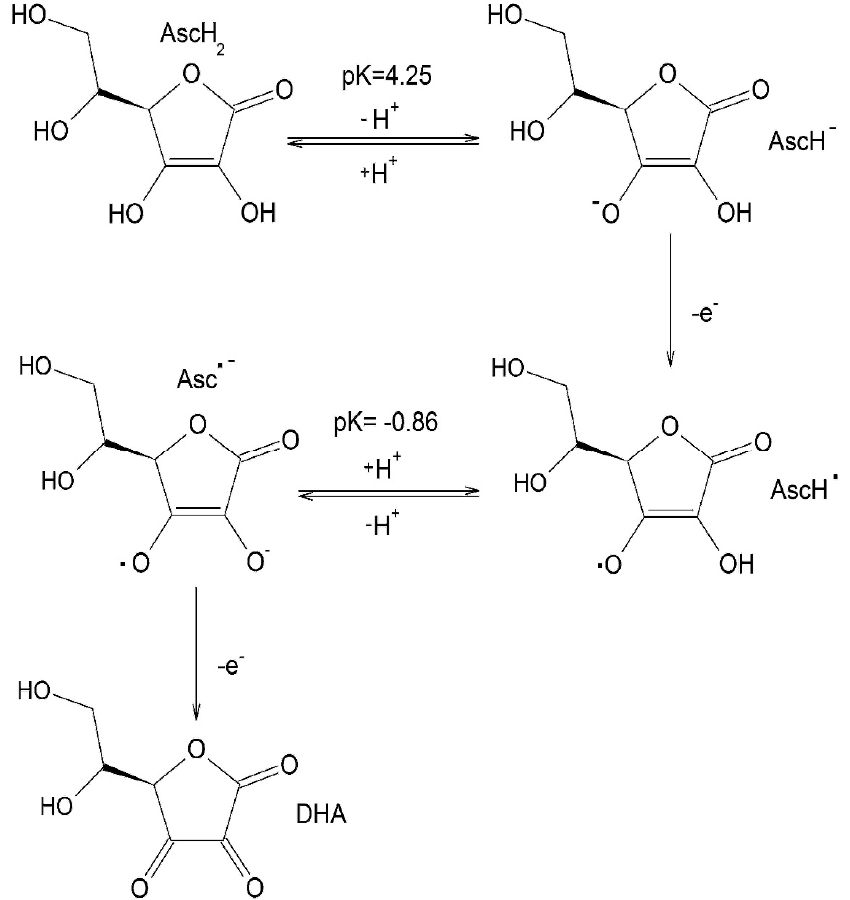
Figure 1. The structures of ascorbic acid (AscH 2 ), ascorbate anion (AscH − ) and its main oxidation products: ascorbyl radical in protonated and deprotonated forms (AscH • or Asc •− ) and dehydroascorbate (DHA) [31,32]. The metal binding site of ascorbic acid consists of the two –OH groups (one, 2-OH on the right hand site and the other 3-OH on the left hand site of the ring structure of AscH 2 ) [32].